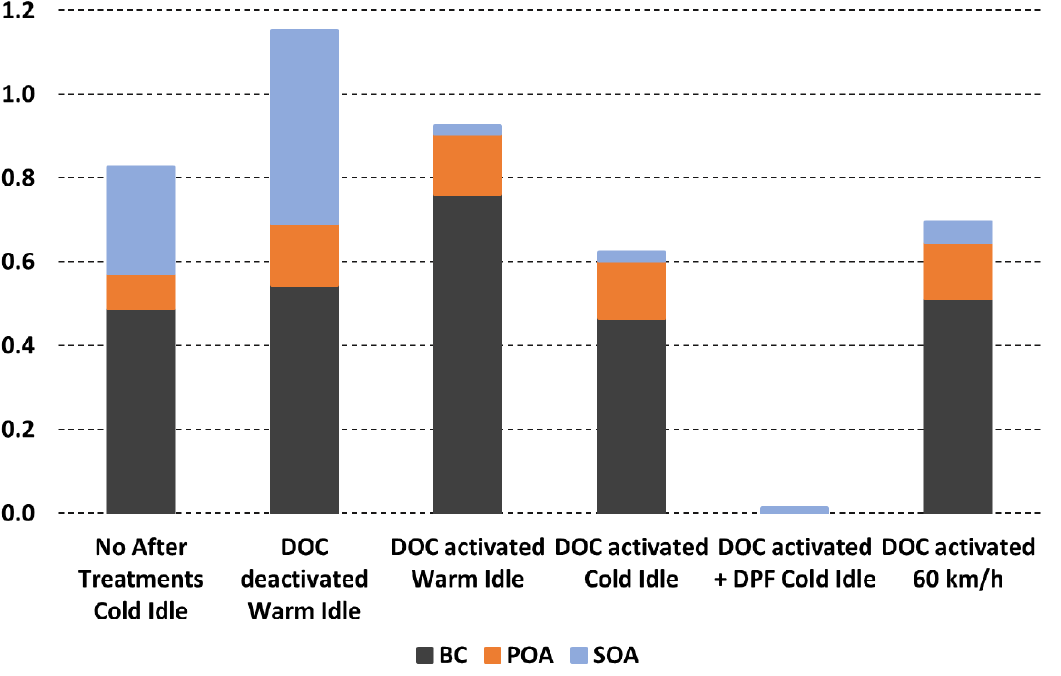
Figure 12. Emission factors of POA, SOA and BC in g kg fuel − 1 from in-use vehicles. SOA produced after 5 h aging. Diagram reproduced from [244].